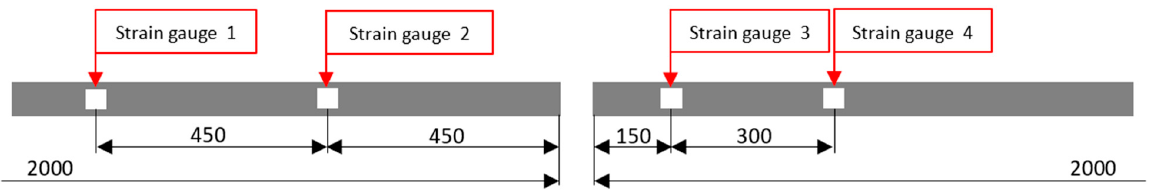
Figure 4. Arrangement of strain gauges on